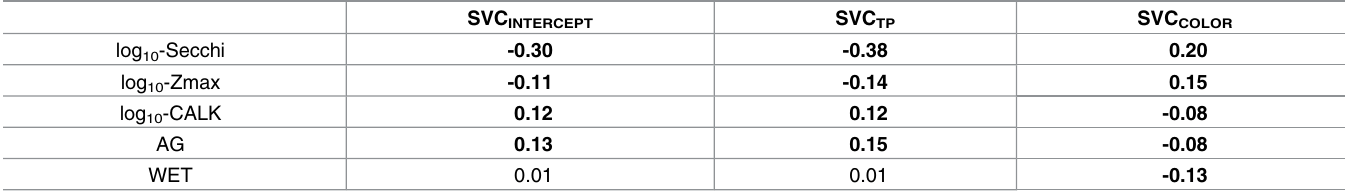
Table 3. Correlation coefficient values for lake-specific spatially-varying coefficients and hypothesized lake and catchment